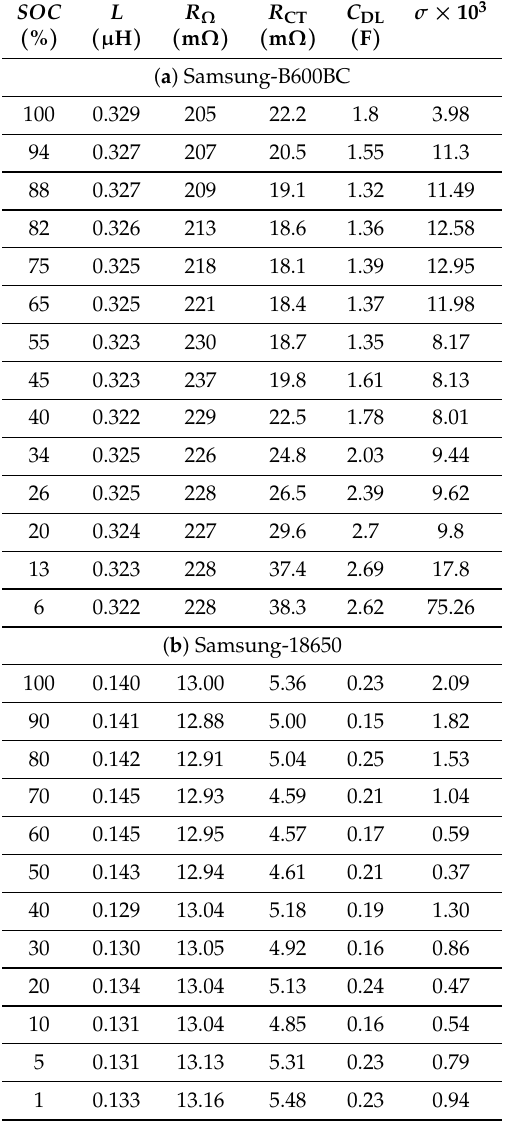
Table 3. Extracted parameters from